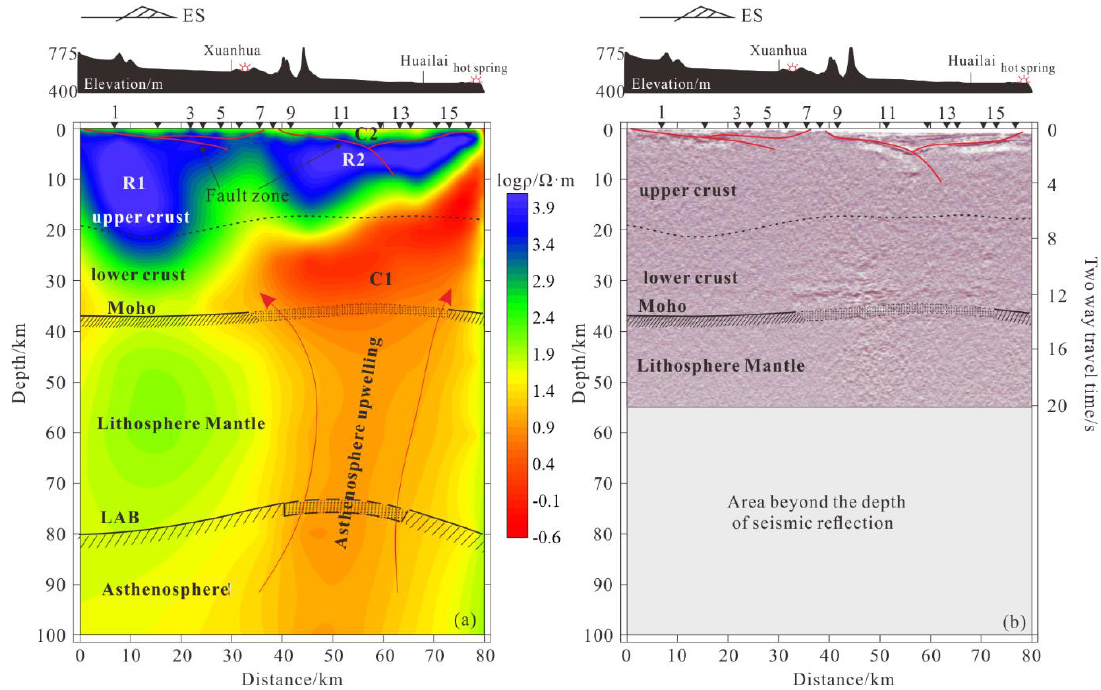
Figure 8. Deep geoelectric structure ( a ) and seismic reflection imaging ( b ) in the Huailai area (seismic reflection imaging modified according to [29]).